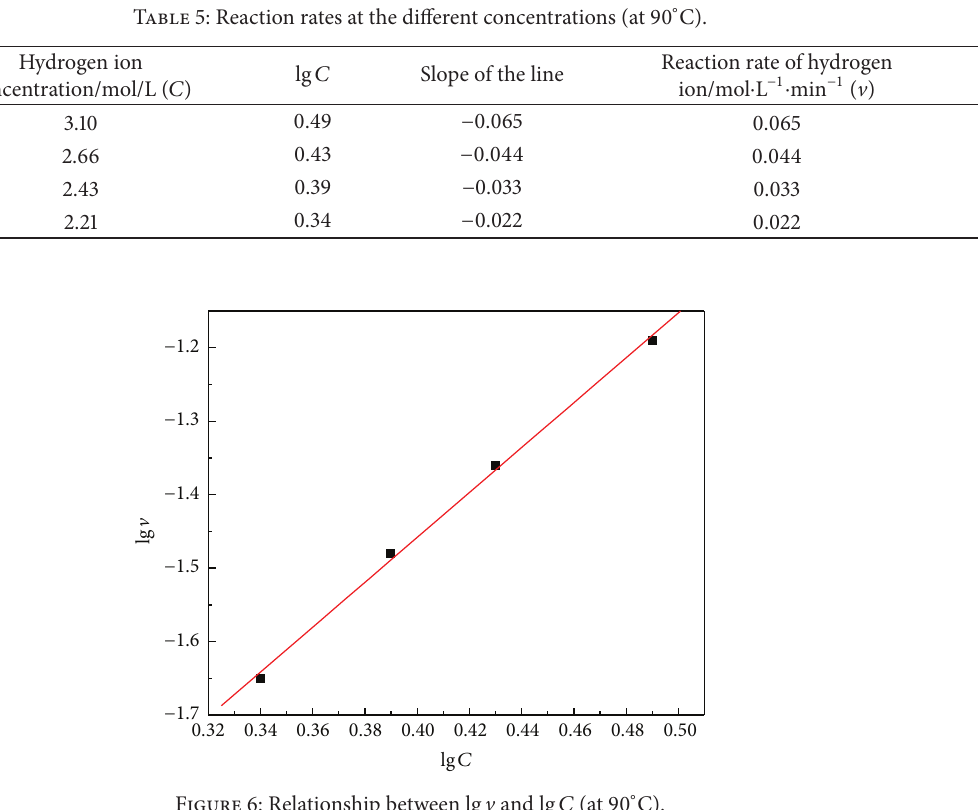
Figure 6: Relationship between lg V and lg 𝐶 (at 90 ∘